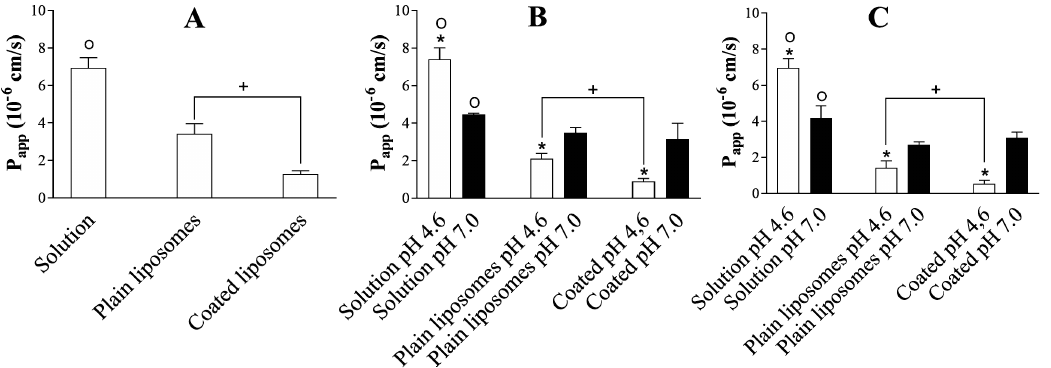
Figure 3. Apparent permeability (P app ) of ibuprofen across the barriers from ibuprofen solution, plain liposomes, and coated liposomes using ( A ) Setup 1 (i.e., naked barriers), ( B ) Setup 2A and B (i.e., mucus pH of 4.6 or 7.0), and ( C ) Setup 3A and B (i.e., mucus + SVF pH of 4.6 or 7.0) (mean ± SD, n = 18).* Represents statistical di ff erence in P app between pH of 4.6 and 7.0 within the same formulation. o Represents statistical di ff erence in P app between ibuprofen solution and both liposomal formulation at the same pH. + Represents statistical di ff erence in P app between plain and coated liposomes at the same